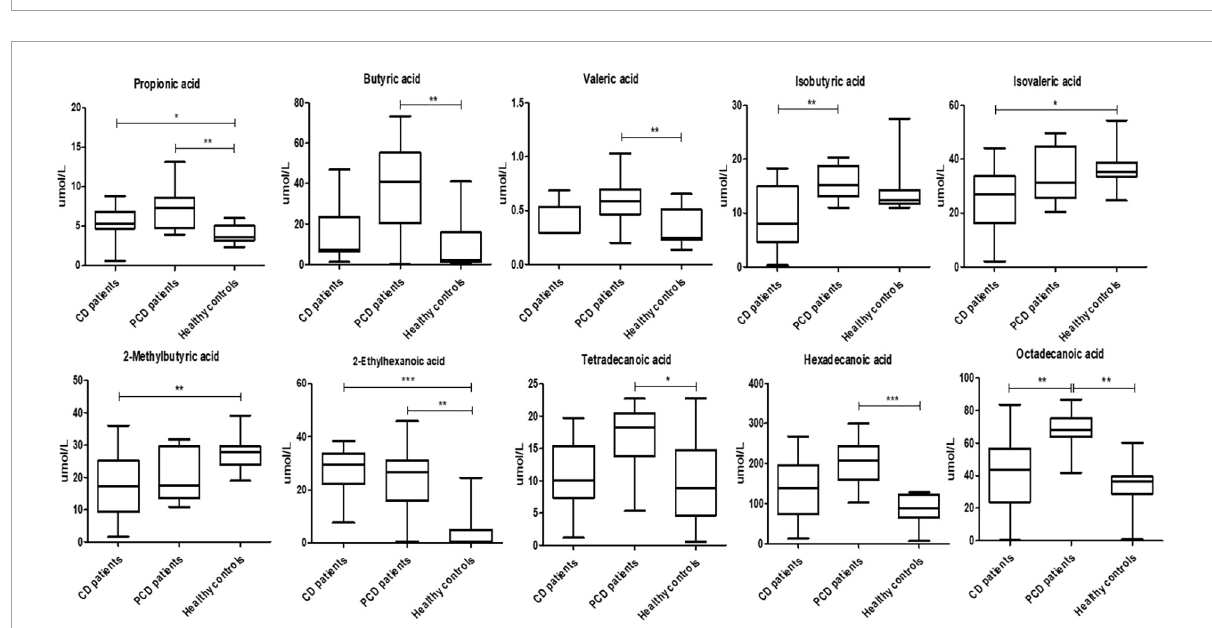
FIGURE4 Boxplots representing the overall abundance of FFAs in aCD patients, pCD patients, and healthy controls ( µ mol/L). P -values of the intergroup comparisons were assessed with Kruskal–Wallis test. P -values less than 0.05 were considered statistically significant. The asterisks * represent p -values, * p < 0.05, ** p < 0.01, *** p <